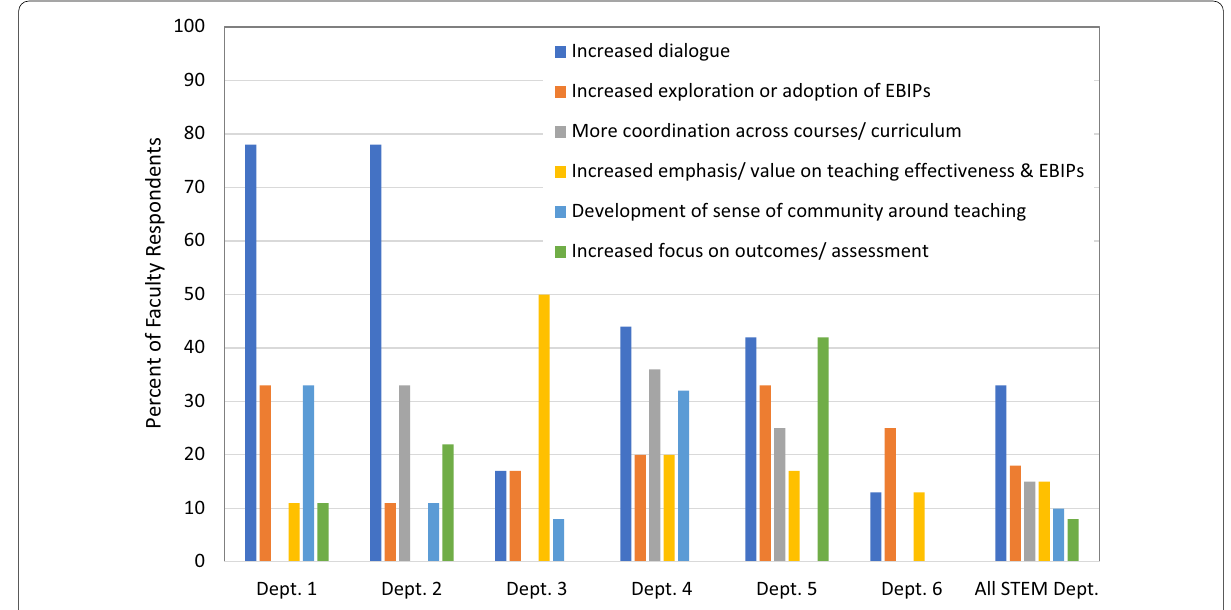
Fig. 1 Percent of faculty respondents reporting departmental changes in teaching practice or